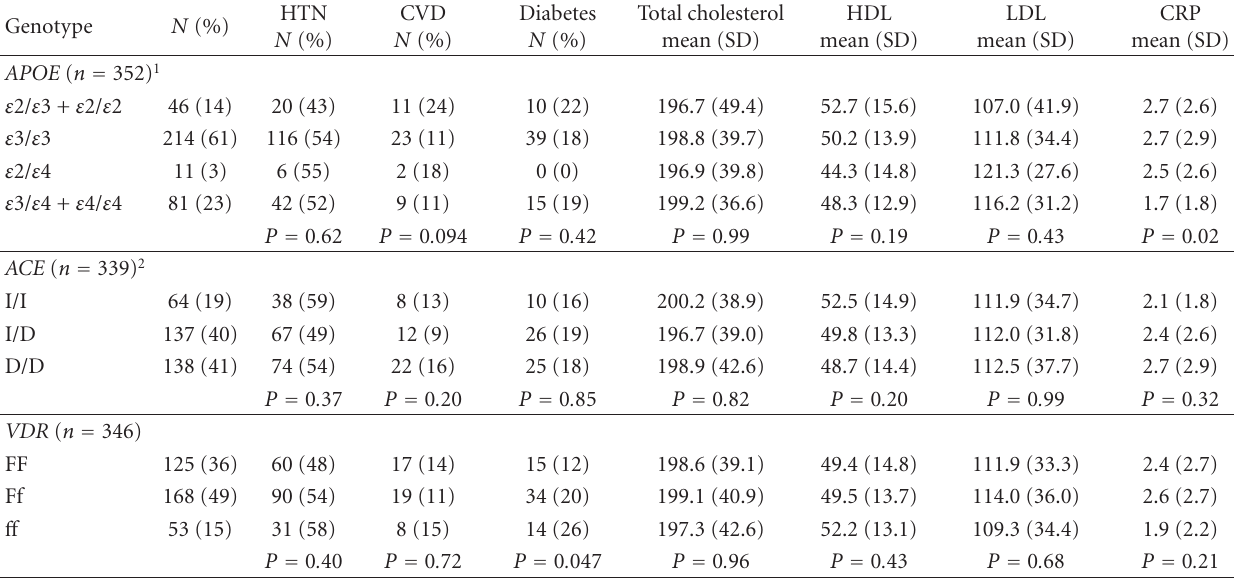
Table 1: Distribution of cardiovascular risk factors by